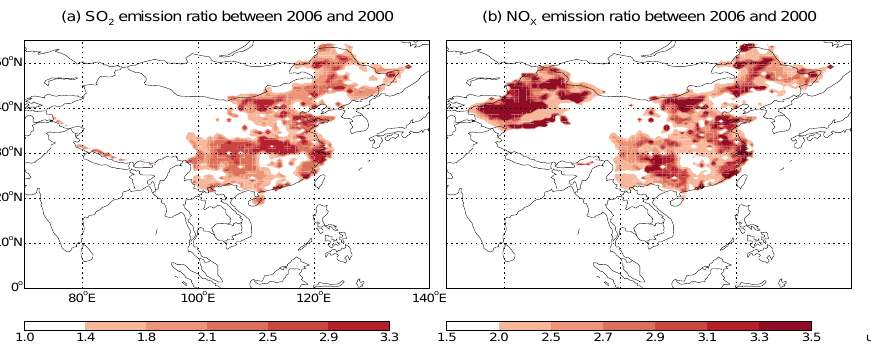
Fig. 11. (a) SO 2 and (b) NO x emission changes from 2000 to 2006 in China. The data shown are the ratios of 2006 emissions to 2000 emissions.